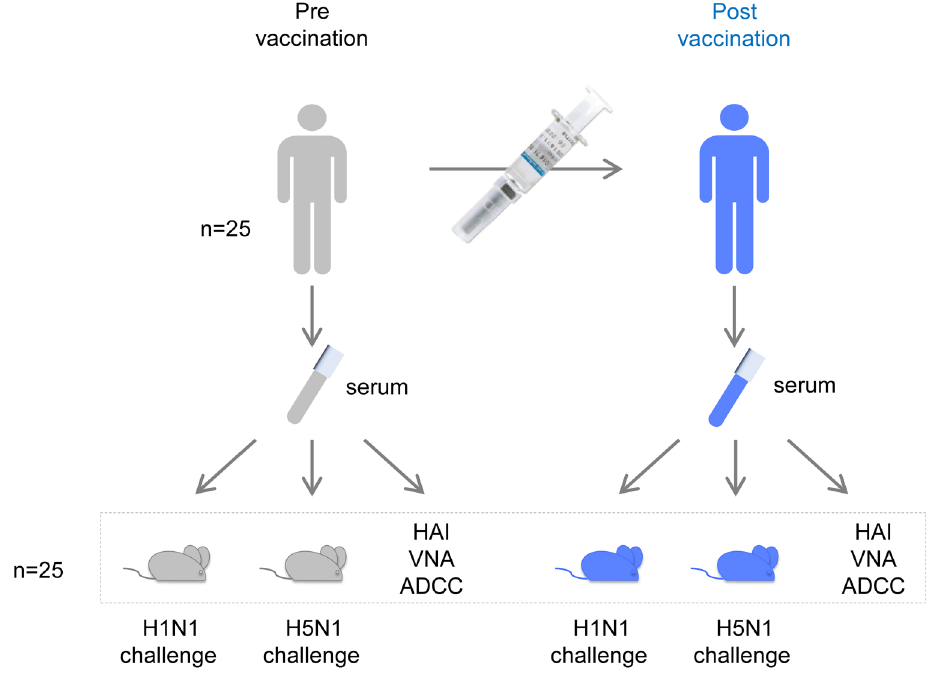
Figure 1. Schematic representation of study design. In a safety and immunogenicity clinical trial (Inf-V-A017), serum was obtained from 25 human subjects before and 4 weeks after vaccination (pre- and post- vaccination serum). To assess the protective activity of the sera, 400 m l of each serum sample was transferred to each of two individual mice which were challenged 24 h later with 25 6 LD 50 of vaccine homologous A/Netherlands/ 602/2009 (H1N1) or heterosubtypic A/Hong Kong/156/97 (H5N1) virus, respectively. In parallel, human sera were characterized for virus-specific immune responses using the hemagglutination inhibition (HAI) assay, virus neutralization assay (VNA), and antibody dependent cellular cytotoxicity (ADCC) assay.